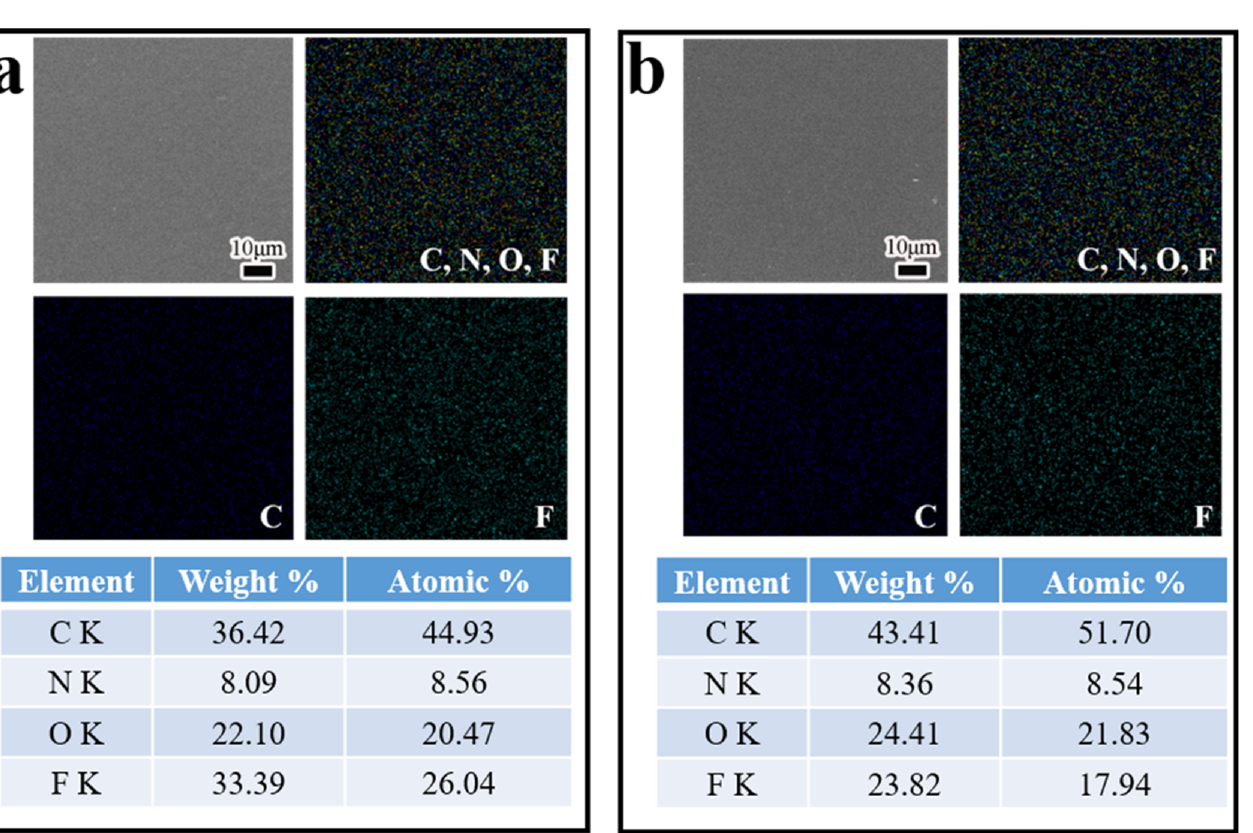
Figure 4. EDX-SEM micrographs of P(CTFE- alt -IBVE)/WPU-T ( a ) and P(CTFE- alt -IBVE)/MFWPU ( b ) coatings prepared, respectively, using TEA and DMAEMA as neutralizers.